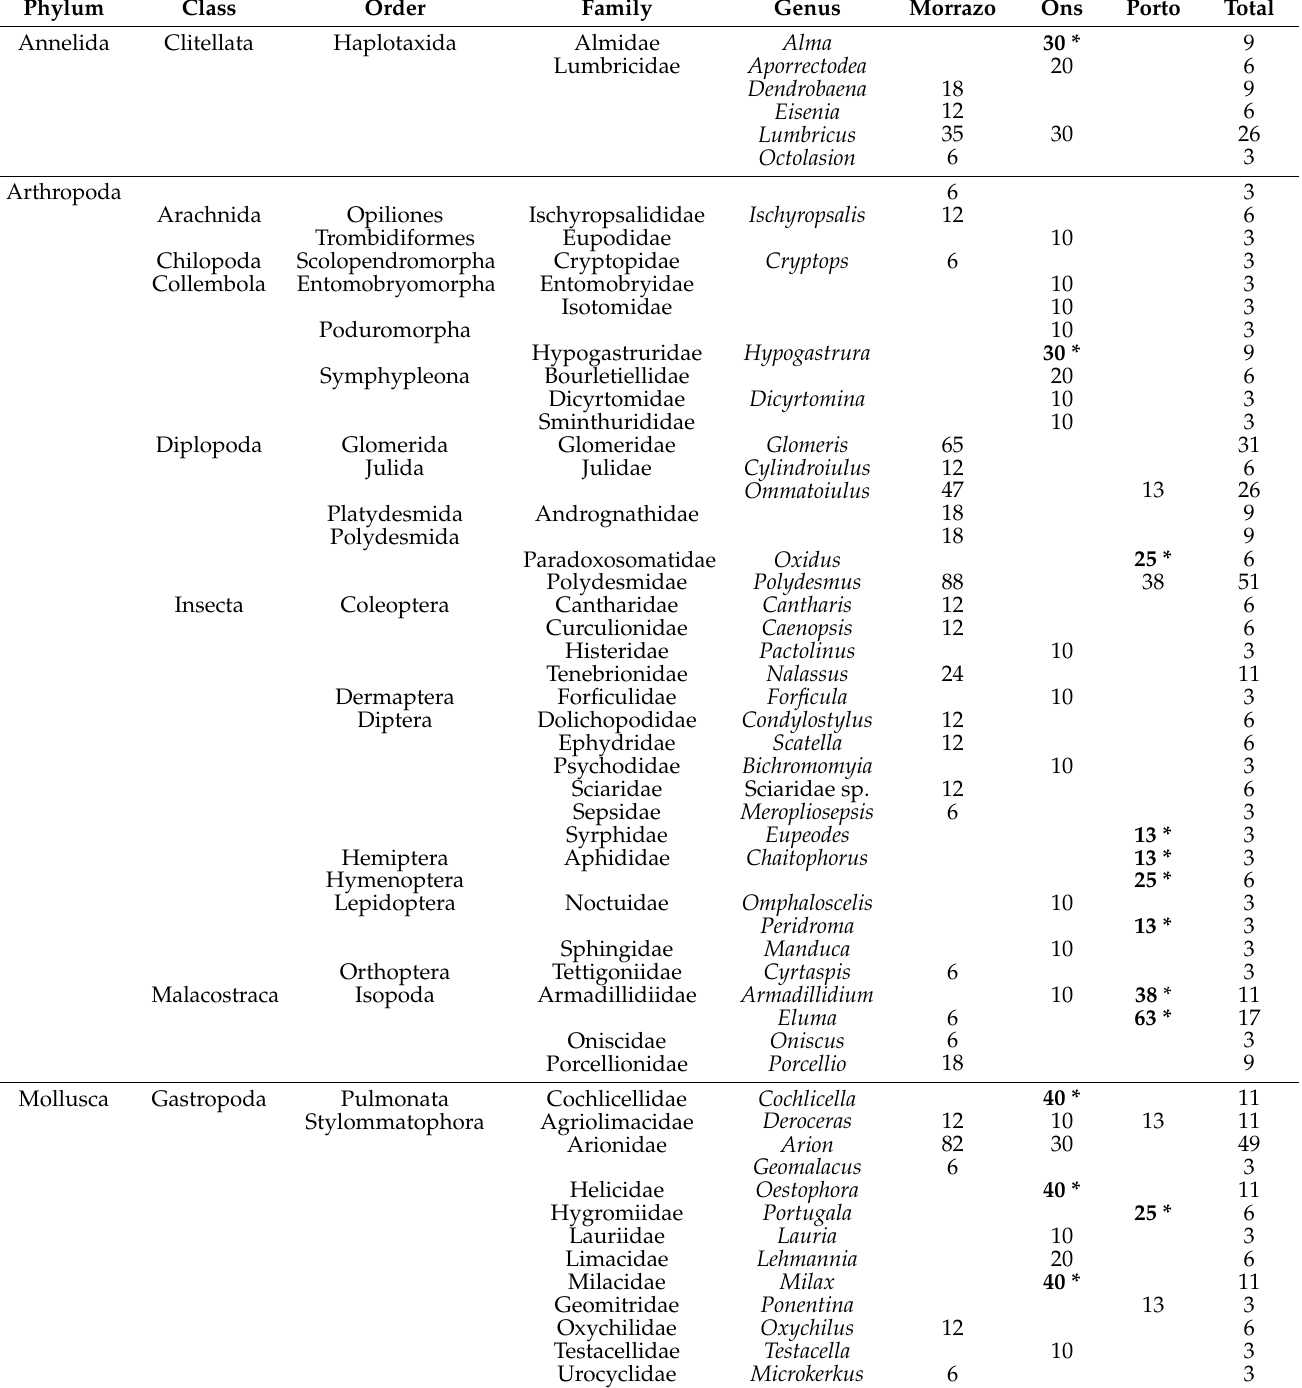
Table 1. The frequency of occurrence of prey taxa observed among samples in each region, and in total. Where an OTU at the genus-level resolution could not be identified, the next highest taxonomic resolution (e.g., family, order, etc.) is provided. Significant differences in pairwise comparisons of average abundance between regions are shown in bold with an asterisk ( p <